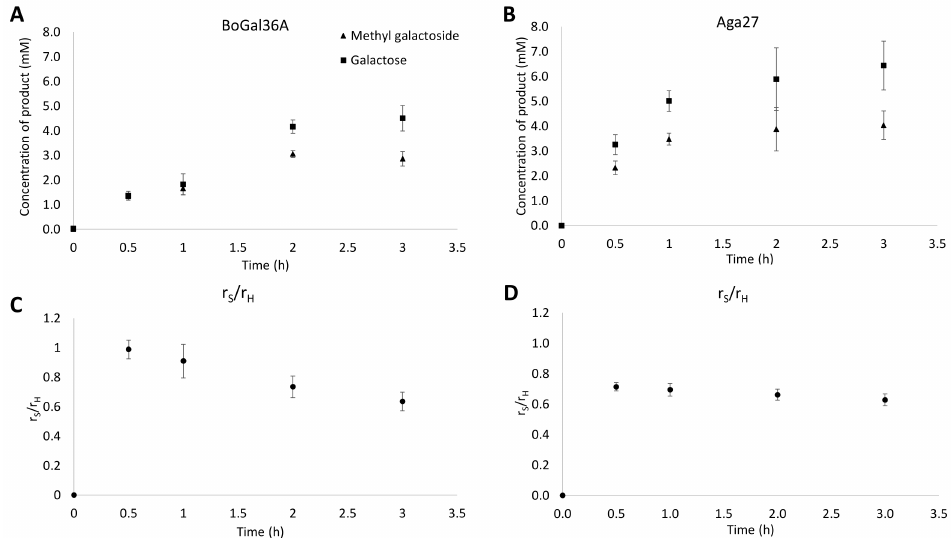
Figure 6. The figure shows the time-resolved reactions with 40 mM raffinose as a glycosyl donor and 10 v/v % methanol as an acceptor incubated with 33 nkat/mL BoGal36A in 50 mM sodium citrate pH 6 ( left side) or 12 nkat/mL Aga27A in 50 mM sodium acetate pH 4.5 ( right side). The concentration of methyl galactoside and galactose over the time course for BoGal36A and Aga27A is shown in panels ( A , B ), respectively, with galactose represented by the box while methyl galactoside is represented by the triangle. The change in apparent r S /r H for the reactions is shown in panel ( C ) for BoGal36A and panel ( D ) for Aga27A. Error bars represent standard deviation for independent triplicate